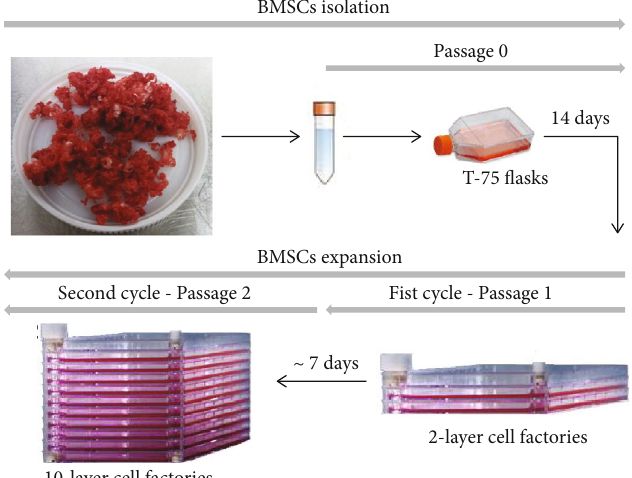
Figure 2: Schematic representation of the in vitro bone marrow stromal cells manufacturing in a GMP-compliant semiclosed system. After bone marrow dissociation from bone spicules, nucleated cells were seeded in T-75 fl asks for BMSC isolation (P0), followed by expansion in 2-layer cell factories (P1) and subsequent expansion in 10-layer cell factories